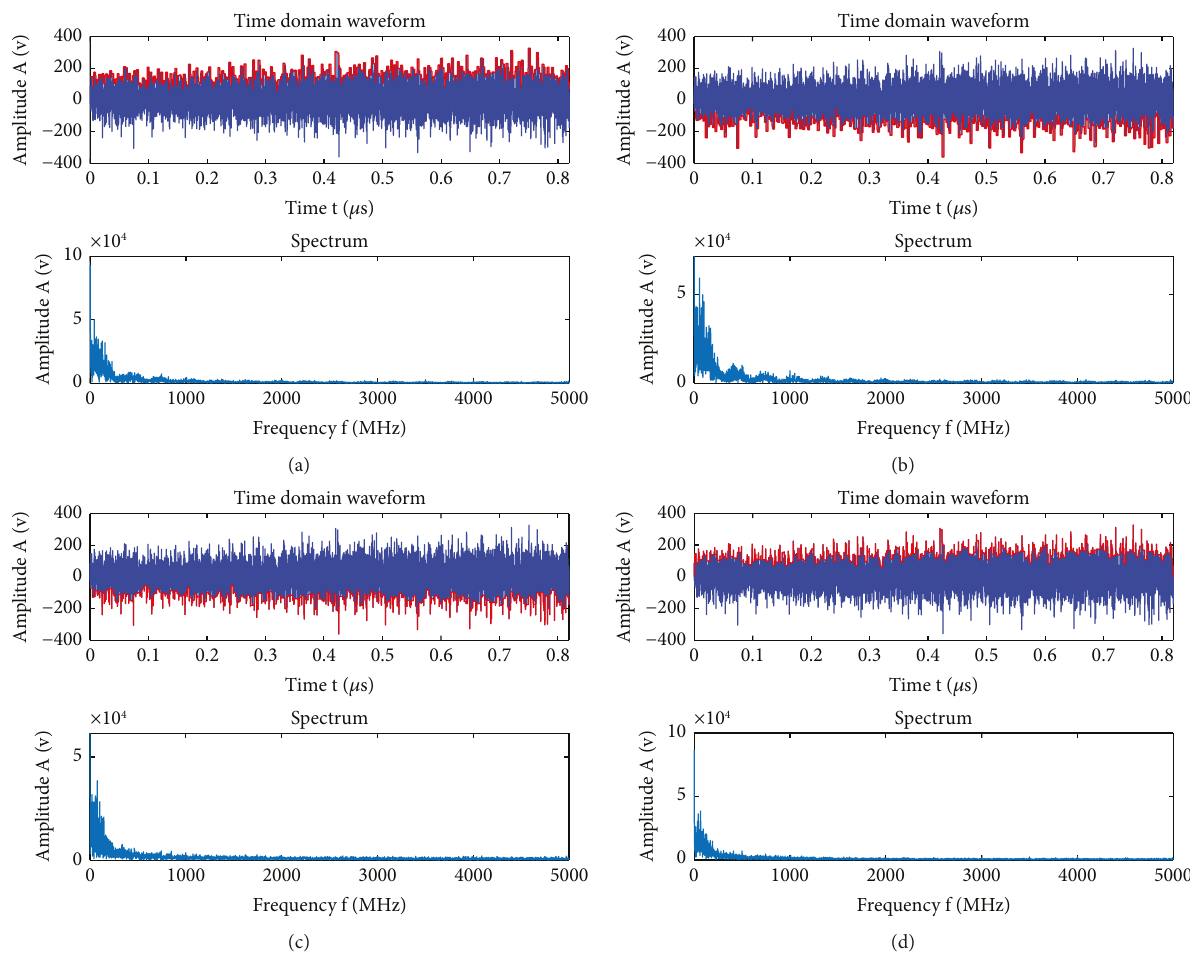
Figure 5: Basic morphological signals and spectrum of (a) dilate, (b) erode, (c) open, and (d) close.